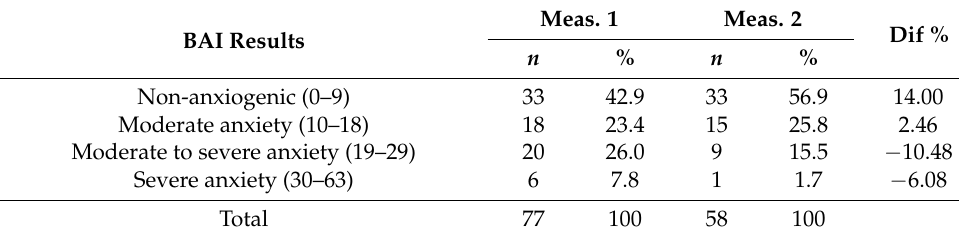
Table 5. Frequency of BAI test results.